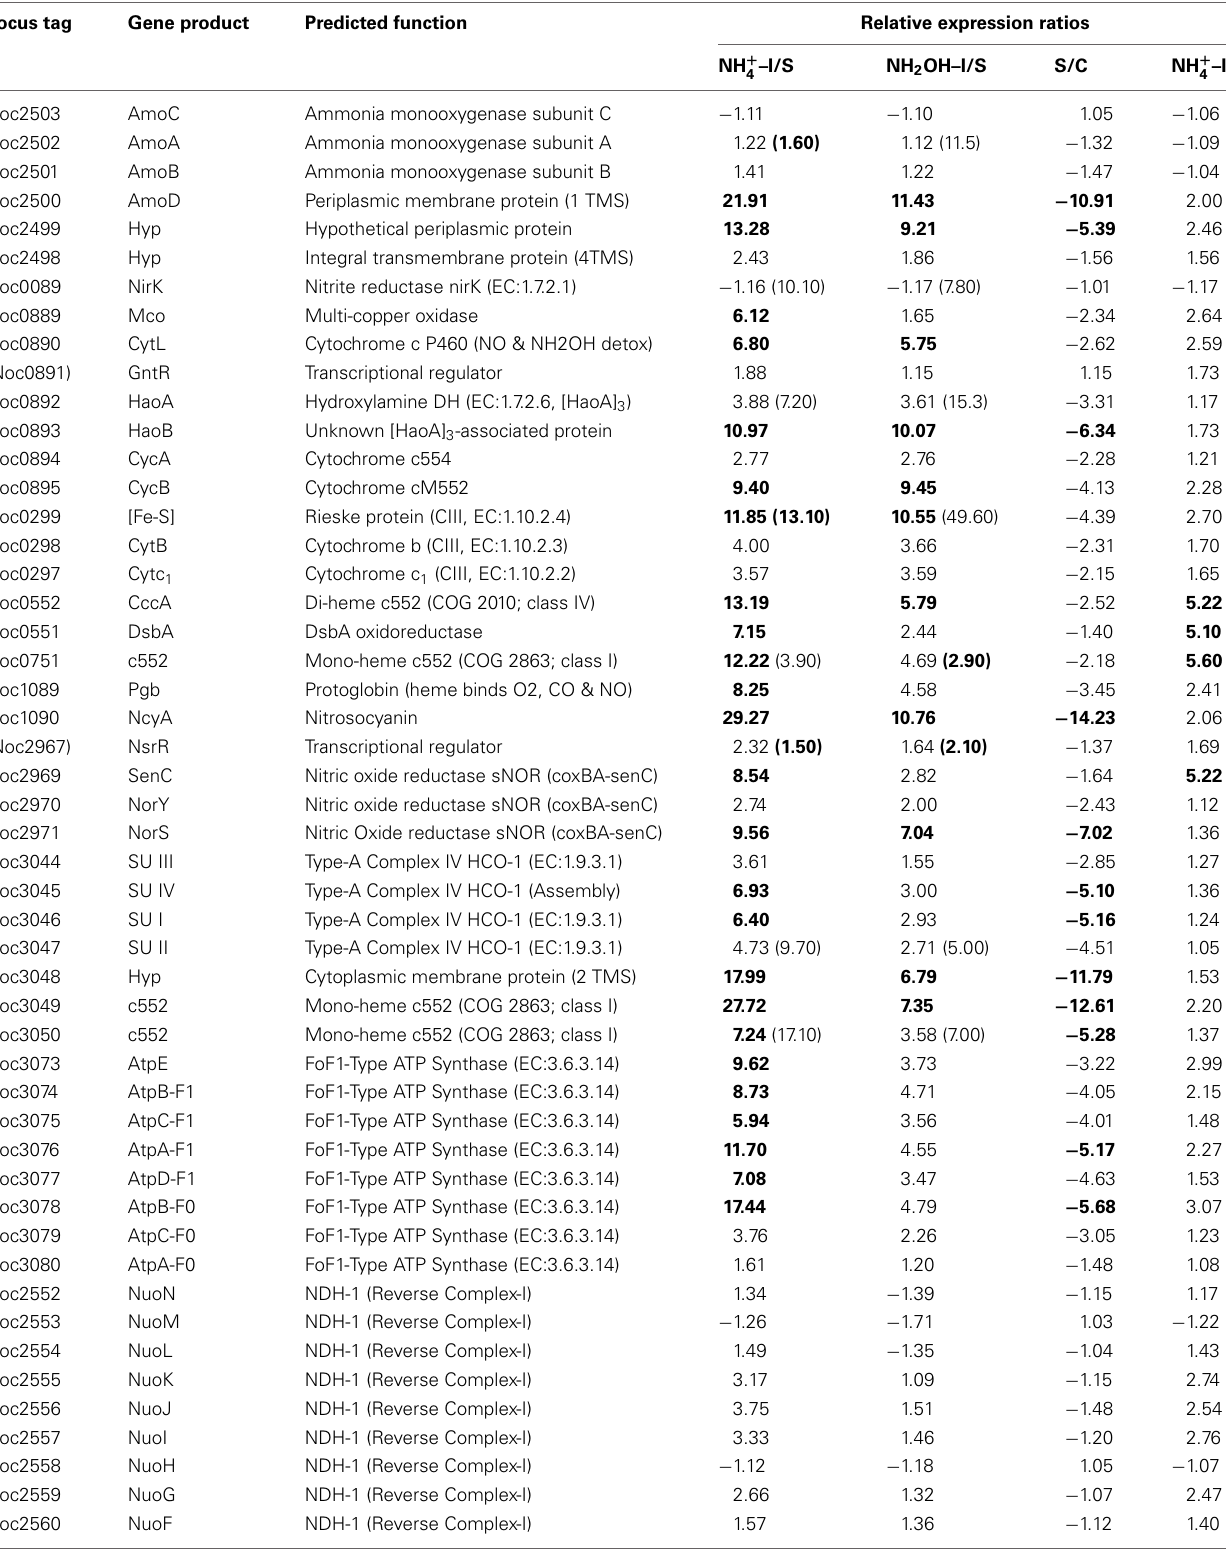
Table 1 | Expression ratios of genes and gene clusters in catabolic modules for “Energy and Primary and Secondary Electron Flow.” Locus tag Gene